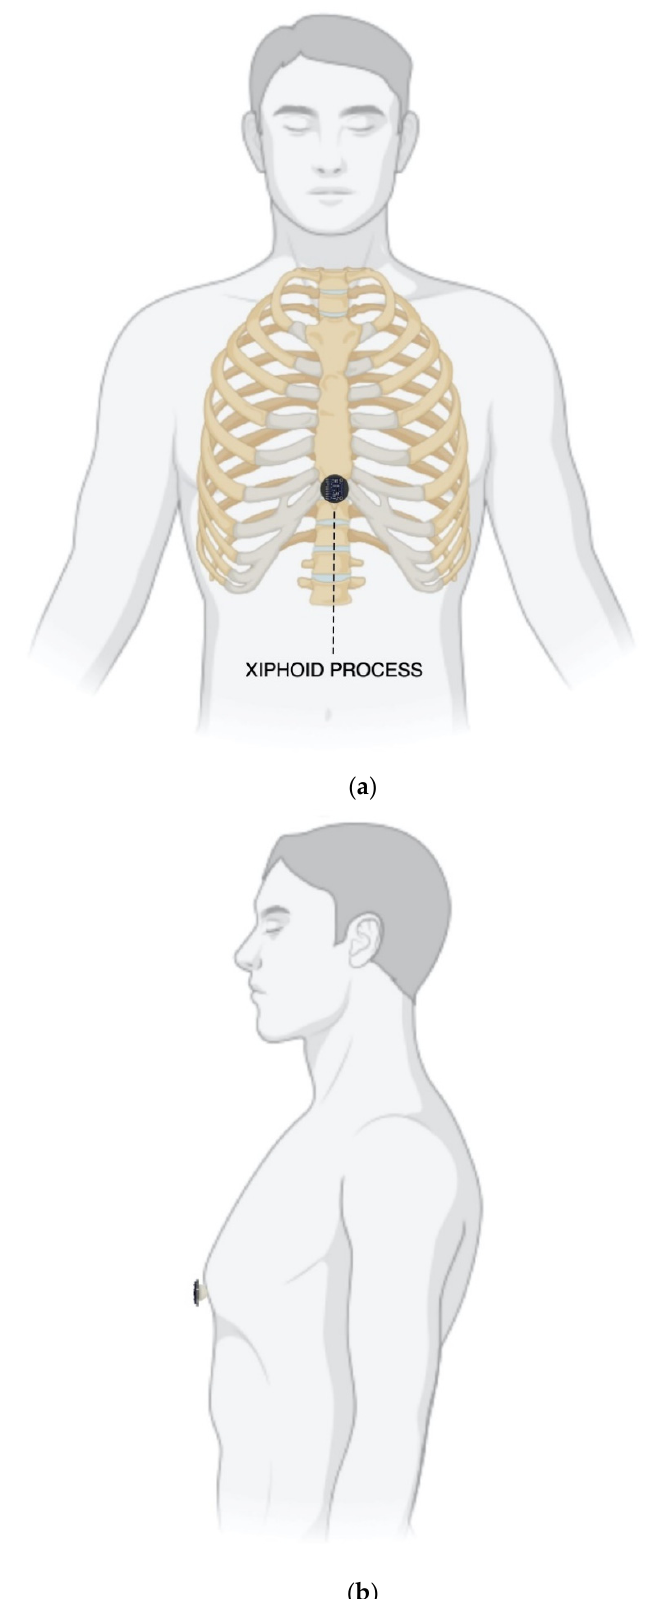
Figure 2. Sensors assembly placement on a subject: ( a ) frontal view; ( b ) lateral